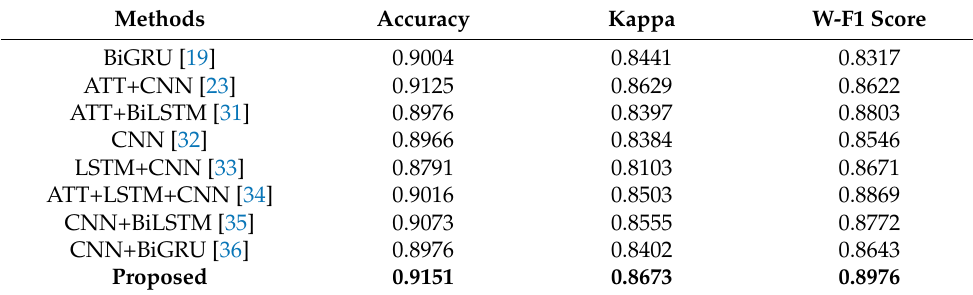
Table 8. Deep learning models performance comparison.